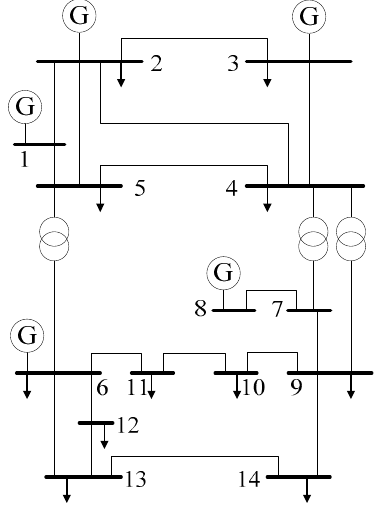
Figure 2. IEEE 14-bus power system.